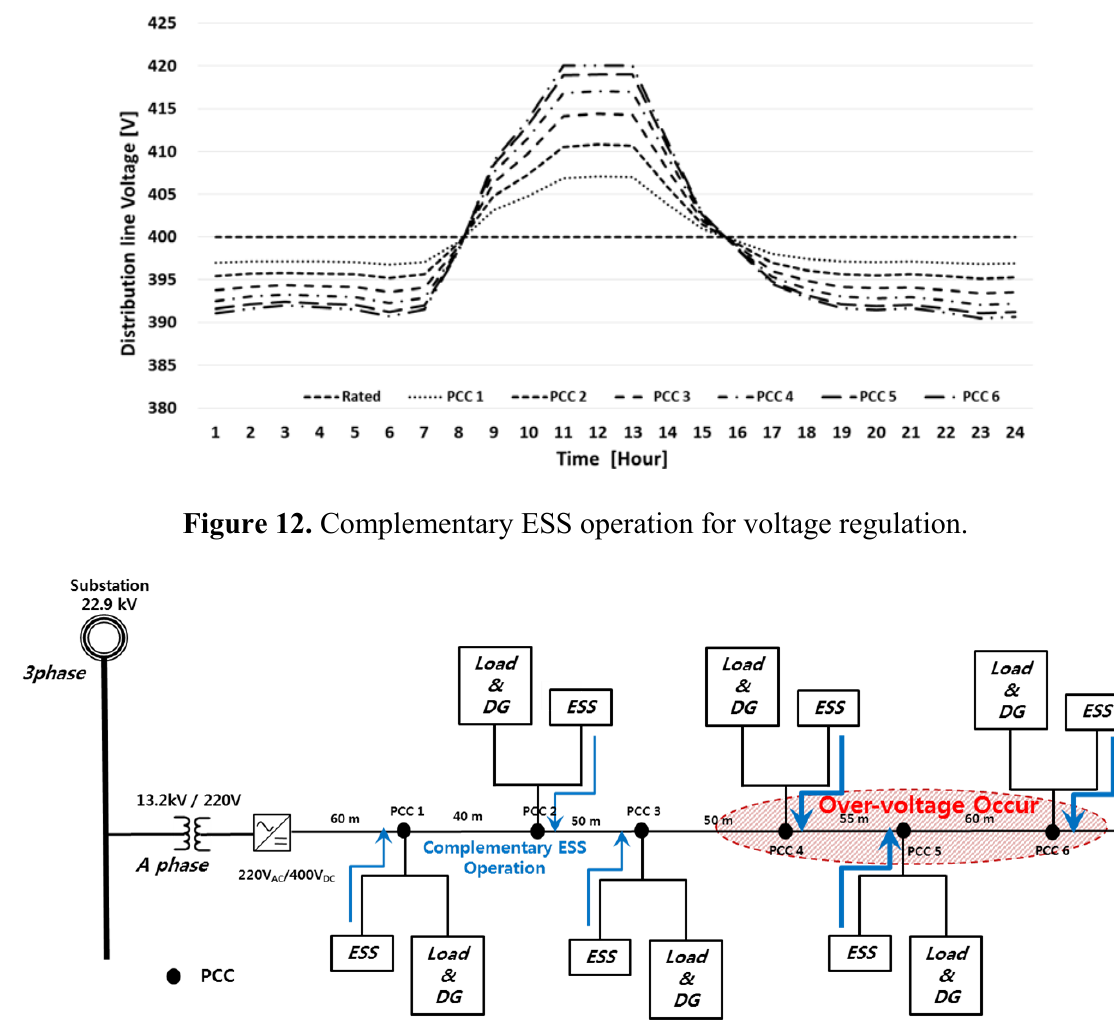
Figure 11. Voltage profile compensated by the ESSs.